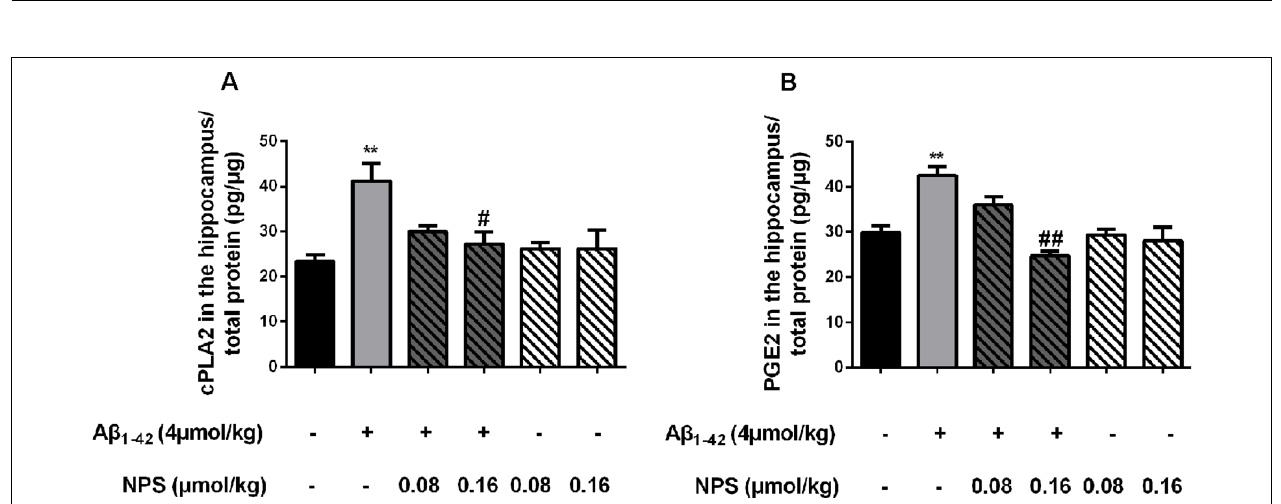
FIGURE 9 | CaSR was involved in A β 1–42 -induced increase of cPLA2 and PGE2 in the hippocampus. (A) Quantitative comparison of the content of cPLA2 in the control, oligomeric A β 1–42 -treated group (4 µ mol/kg), and/or NPS 2143-treated group (0.08 or 0.16 µ mol/kg). (B) Quantitative comparison of the content of PGE2 in six groups. # P < 0.05 vs. A β 1–42 oligomer-treated group, ** P < 0.01 vs. control group, ## P < 0.01 vs. A β 1–42 oligomer-treated group. Values represent mean ± SEM, n = 6 animals for each group.